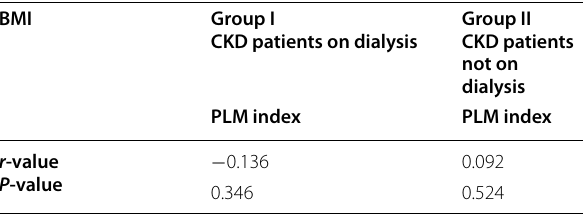
Table 6 Correlation of PLMs with BMI in both groups of